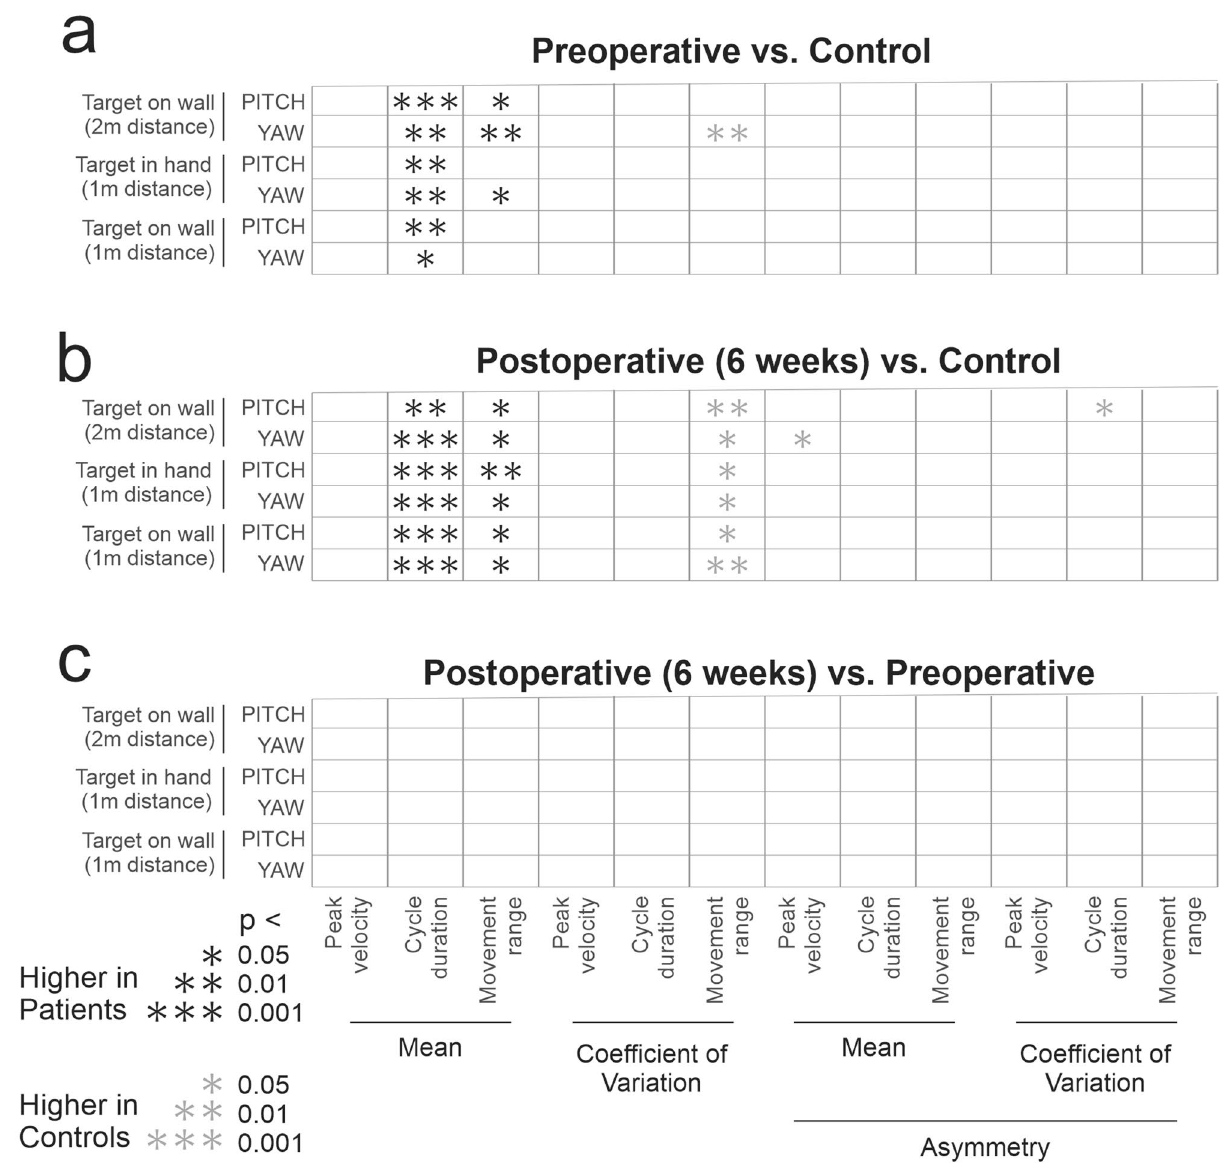
Figure 3. Comparison of kinematic measurements between ( a ) pre-surgery patients and healthy controls, ( b ) post-surgery patients and healthy controls, ( c ) pre-surgery patients and post-surgery patients. The kinematic measurements are arranged horizontally. The 6 exercises are arranged vertically. Asterisks indicate differences at three significance level (*0.05, **0.01. ***0.001). Black asterisks indicate the first group as indicated in the title had a larger value than the second group and grey asterisks indicate the first group had a smaller value than the second